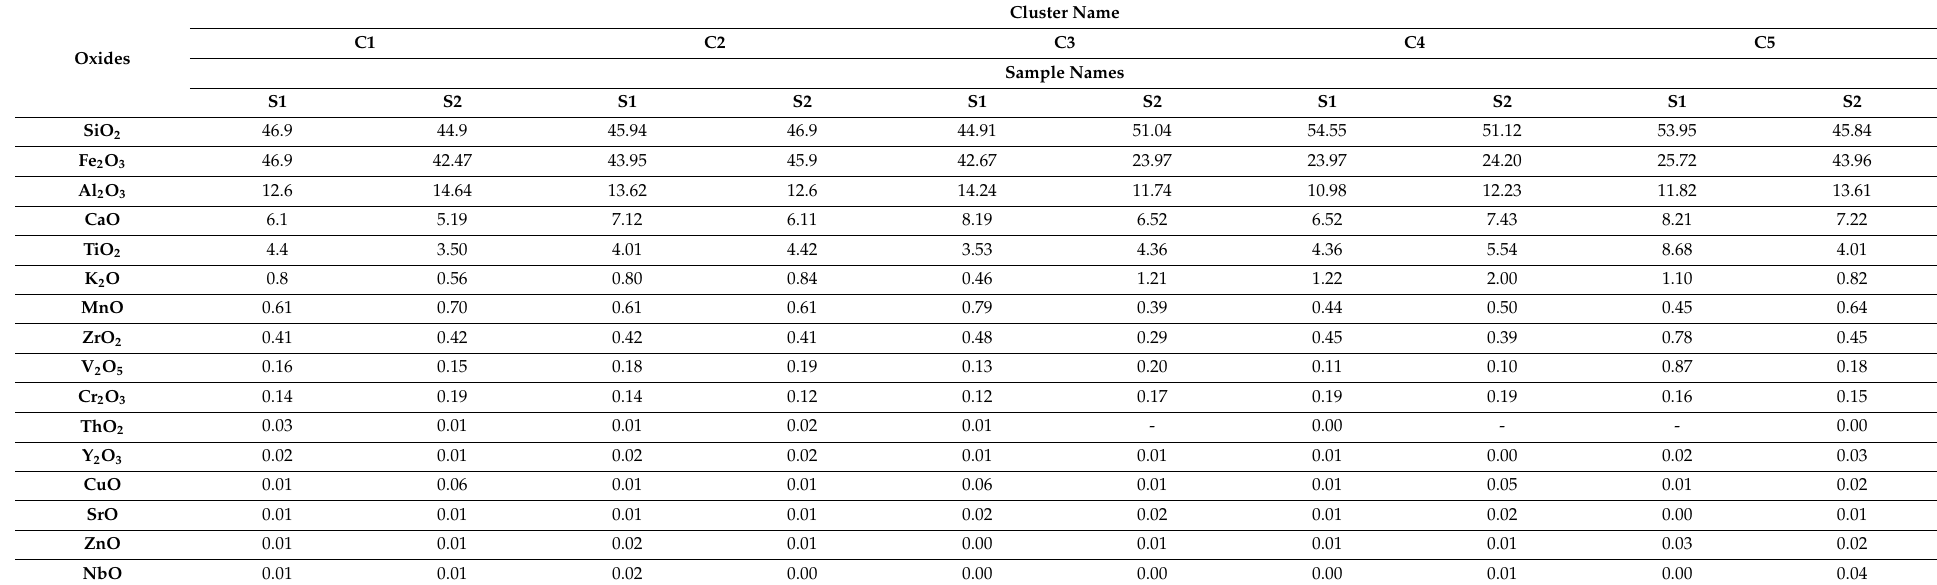
Table 4. Overall Indus River sand composition (in weight %).